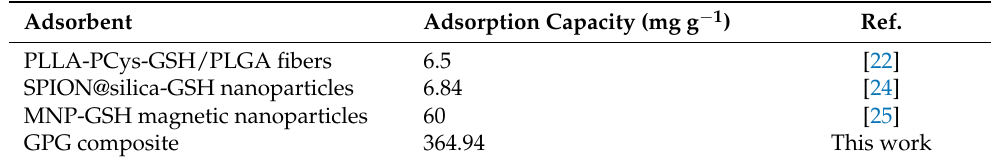
Table 1. GST adsorption capacity on different materials.